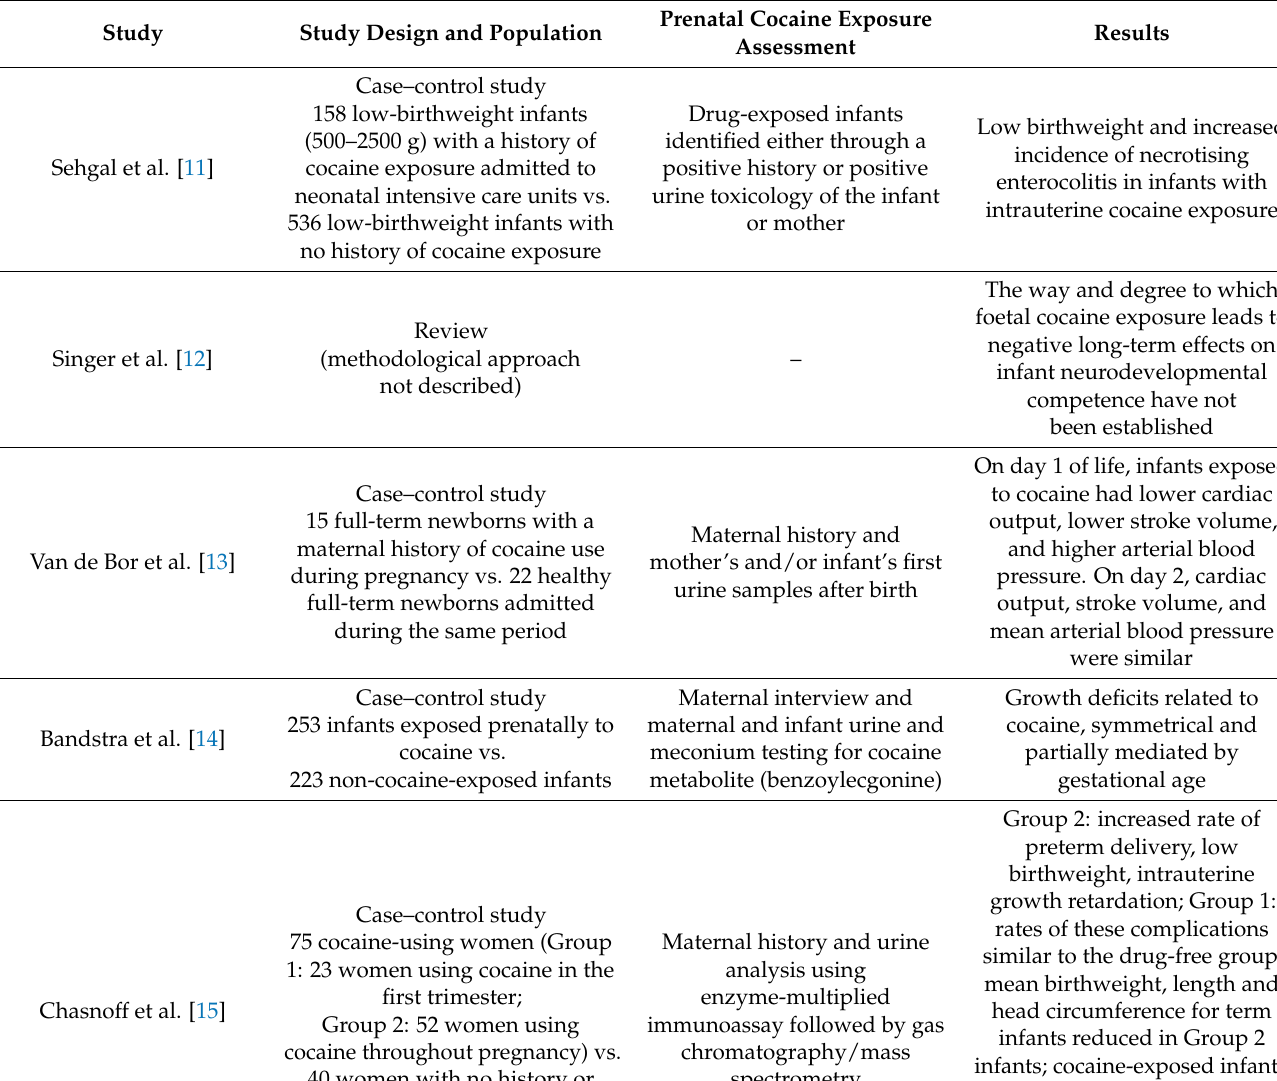
Table 1. Populations, determination of cocaine exposure, and results of the reviewed